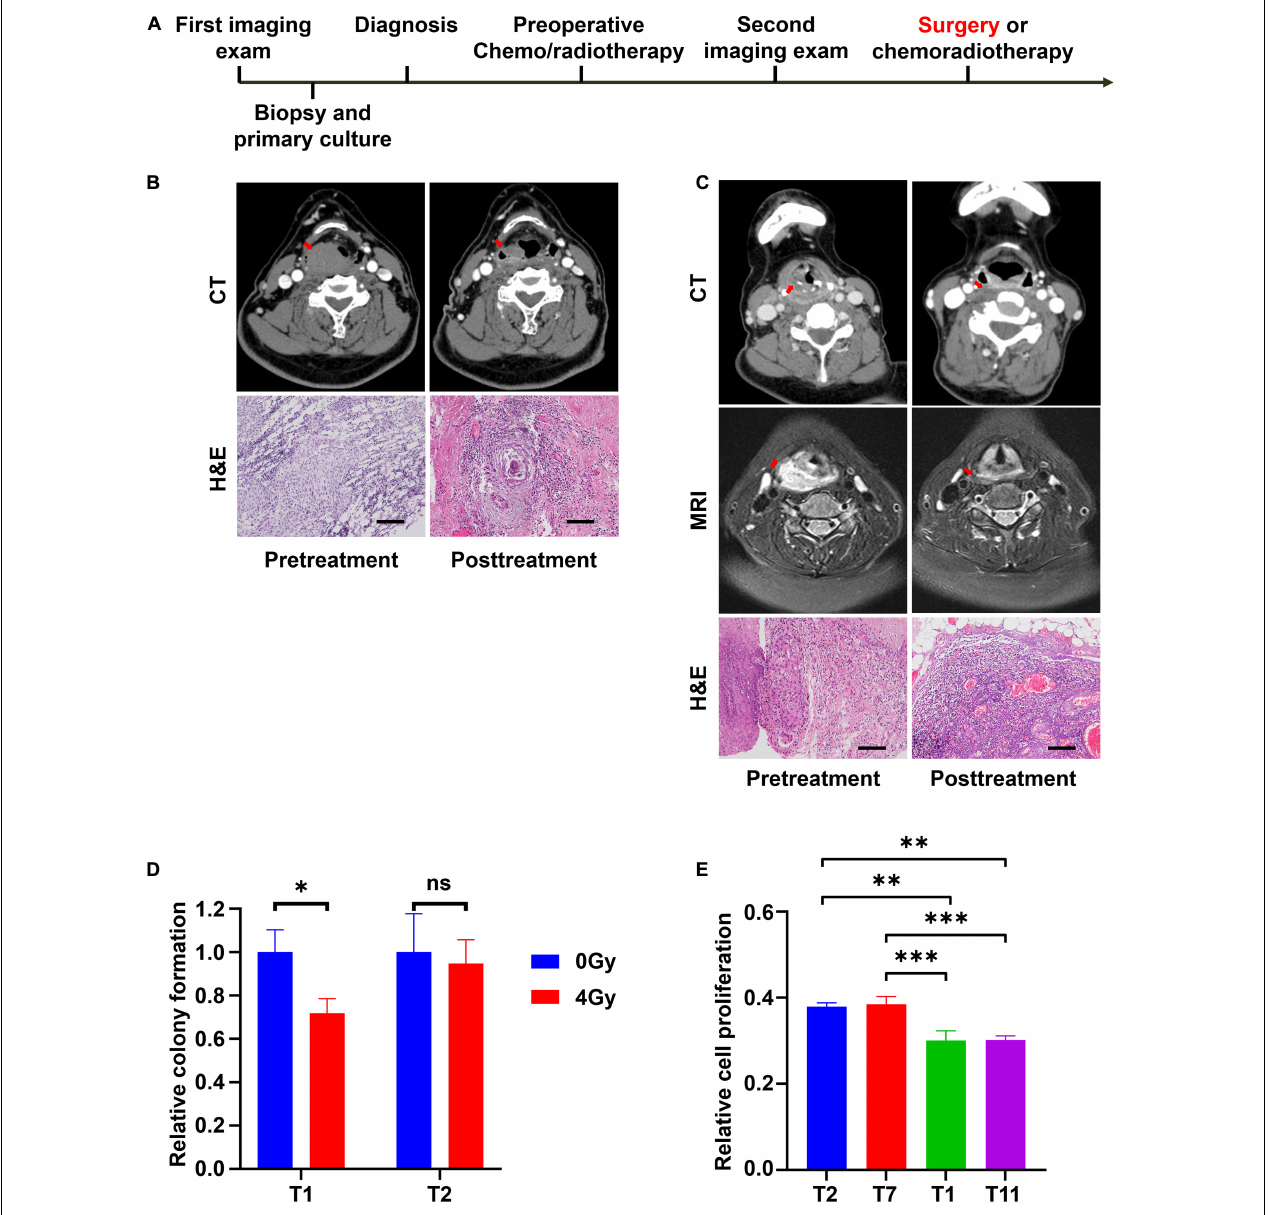
FIGURE 6 | CRCs reflect the clinical outcomes of representative patients with LHSCC. (A) The timeline of diagnosis and treatment procedure for patients receiving preoperative chemotherapy or radiotherapy before surgery. (B) CT images and microscopic images of tumor tissues of patient T11 before and after chemotherapy. The size of the primary tumor, indicated by a red arrow, decreased more than 50%. Microscopic morphologies indicated pathologic complete response after chemotherapy. Scale bar, 250 µ m. (C) CT and MRI images and microscopic images of tumor tissues of patient T13 before and after chemotherapy. The size of the primary tumor (red arrow) decreased. Microscopic morphologies indicated pathologic complete response after chemotherapy. Scale bar, 250 µ m. (D) Relative colony formation of T1 and T2, 7 days after treatment with 0 Gy or 4 Gy radiation. ∗ P < 0.05. (E) Relative cell proliferation of T1, T2, T7, and T11, 3 days’ culture after treatment with 4 Gy radiation. ∗∗ P < 0.01, ∗∗∗ P <